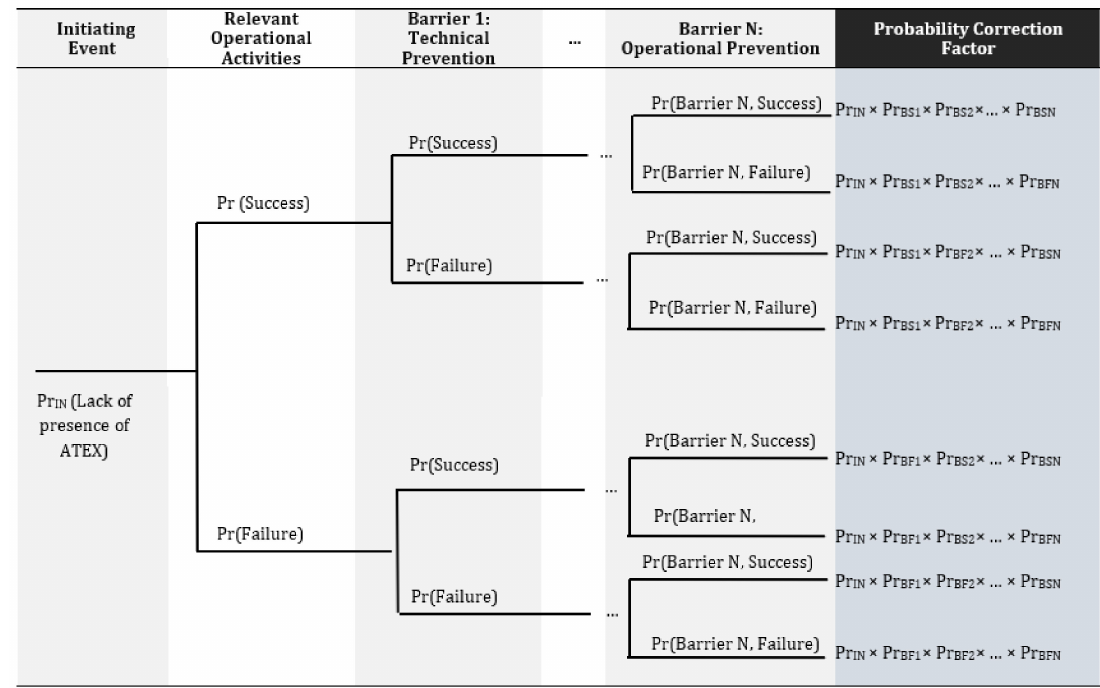
Figure 4. Event tree structure for the external zone determination.